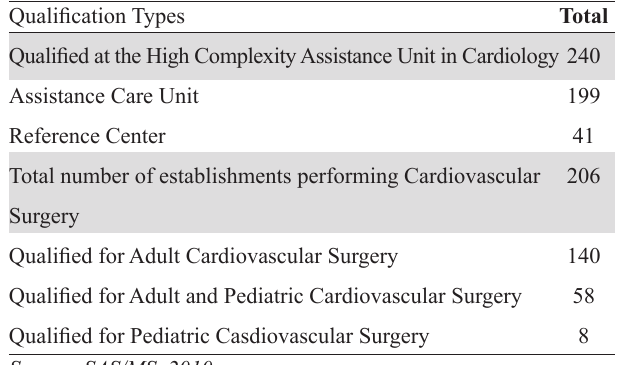
Table 1. Distribution of High Complexity Assistance Unit in Cardiology